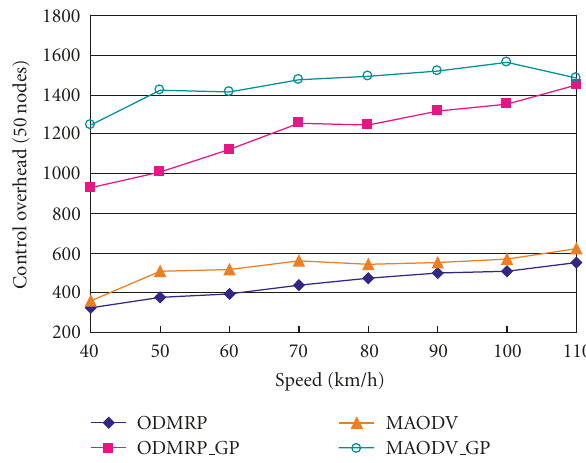
Figure 17: Control overhead versus mobility speed (50 nodes).